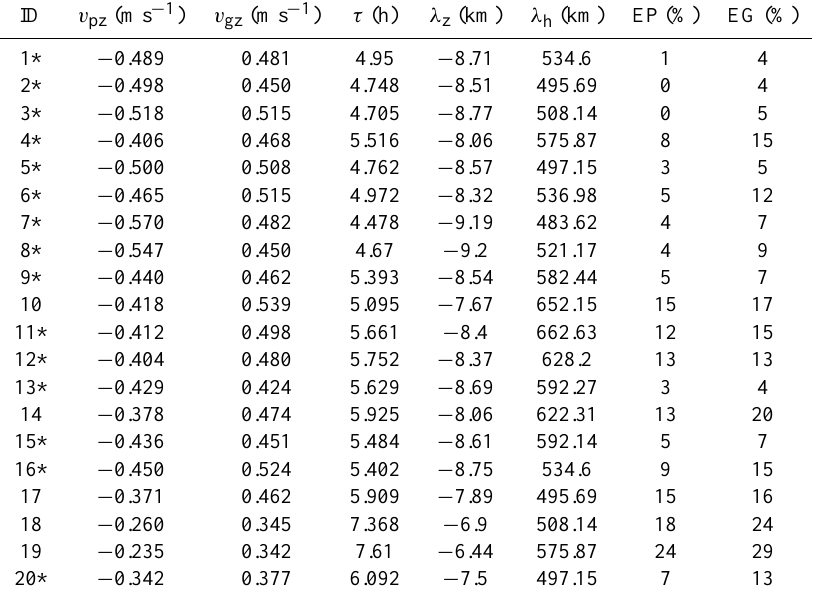
Table 3. Results of wave packet analysis. Vertical wavelength λ z with negative sign indicates downward phase propagation. The star (*) sign indicates the event satisfies dispersion equation under following condition: and EP are, respectively, the percentage error of vertical group and phase velocities: (cid:12) (cid:12)(cid:0) (cid:12) v gz − ˜ v gz (cid:1)(cid:14) v gz EG = (cid:12) ×